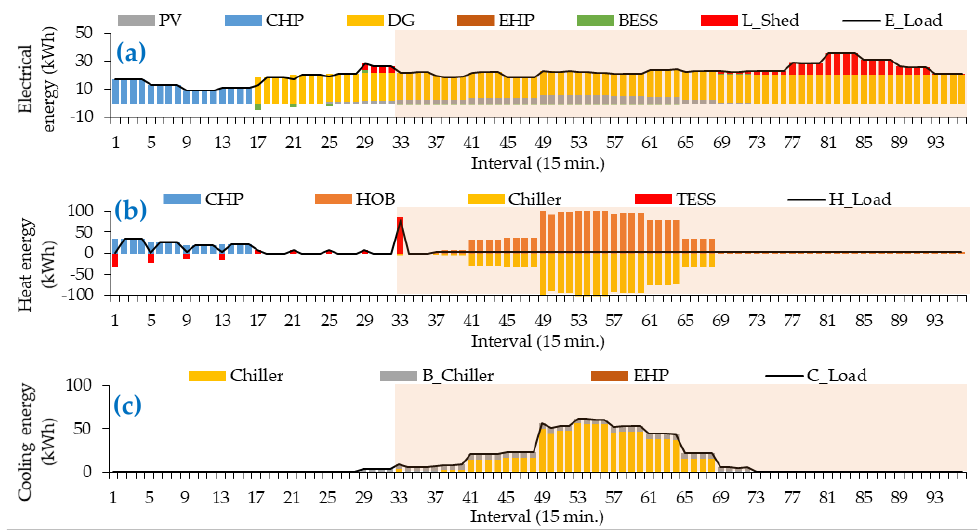
Figure 9. Energy balancing: ( a ) Electrical Energy; ( b ) Heat Energy; ( c ) Cooling Energy.